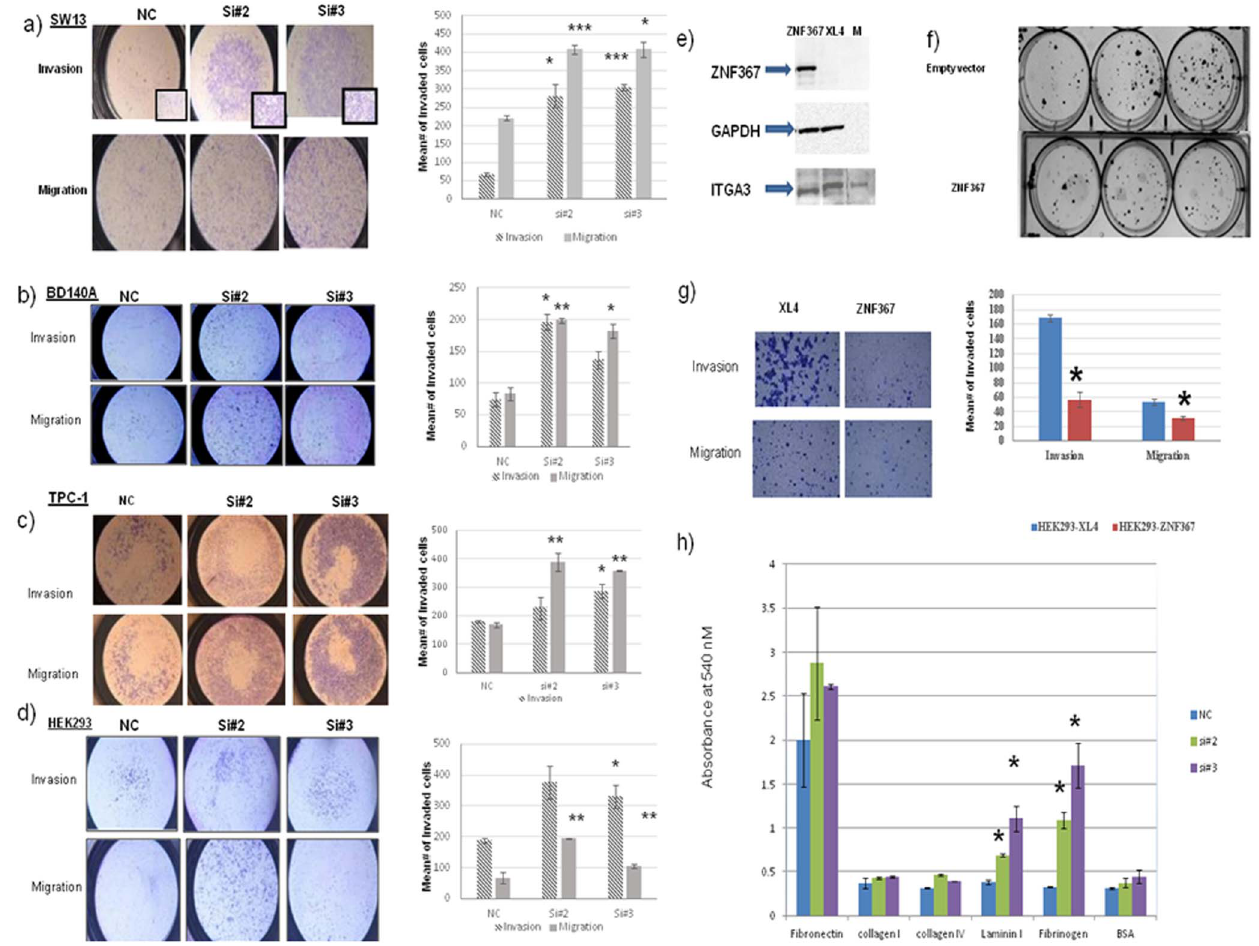
Figure 3. Effect of ZNF367 knockdown and overexpression. ZNF367 overexpression decreases cellular invasion and migration. ( A ) SW13, ( B ) BD104A, ( C ) TPC-1, and ( D ) HEK293 cell lines. After transfection, cells were plated inside a Boyden chamber for 48 hours. Cells were stained and counted in 4 fields. The left panel shows the representative image (12.5X) from the siRNA knockdown and negative control groups. The right panel indicates the quantitative measurement of invaded and migrated cells in knockdown and the negative control. *p , 0.05 and error bars indicate 6 SD. ZNF367 overexpression decreases colony number, cellular invasion, and migration in HEK293 cells. ( E ) Western blot of ZNF367 overexpression in HEK293 and SW13 cells (Empty vector, XL4). GAPDH was used as a loading control. ( F ) Representative clonogenic image for cells with ectopic ZNF367 expression and its corresponding control (Empty vector, XL4). ( G ) Cellular invasion and migration decreased with ZNF367 overexpression in HEK293 cells. The quantitative measurement of invaded and migrated cells per group (HEK293-HEK293-Empty vector or ZNF367 ) is represented in the bar graph on the right panel. ( H ) The extracellular protein attachment of SW13 cells with ZNF367 knockdown. Cells were transfected with ZNF367 siRNA and negative control siRNA, and were plated into adhesion plates and incubated for 90 minutes. The Y axis represents absorbance at 540 nM of cells adherent to each protein. Error bars represent 6 SEM. *p , 0.05, ***p , 0.001.